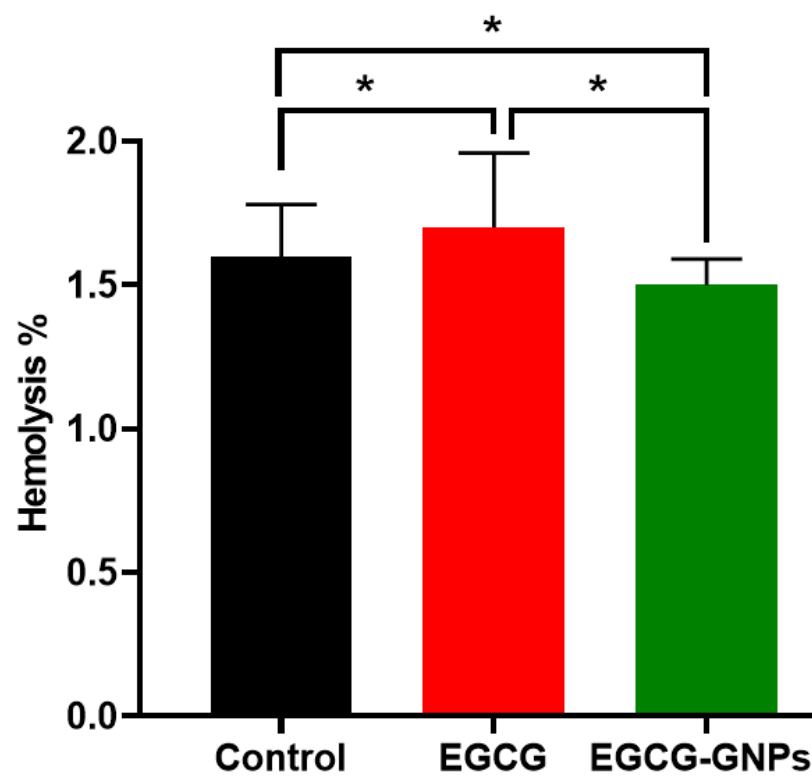
Figure 6. Hemolytic effect of epigallocatechin-3-gallate (EGCG) and epigallocatechin-3-gallate gold nanoparticles (EGCG-GNPs). * Statistically significant difference ( p < 0.05). Blood hemolysis caused by EGCG or EGCG-GNPs was less than 2% confirming their hemocompatibility.